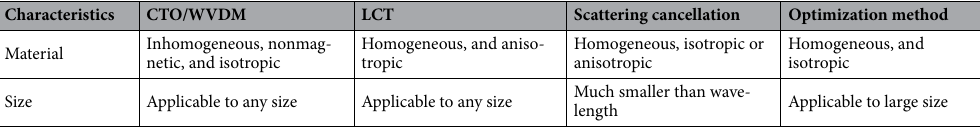
Table 1. Comparison of the optimization method proposed in this paper with other illusion design methods.